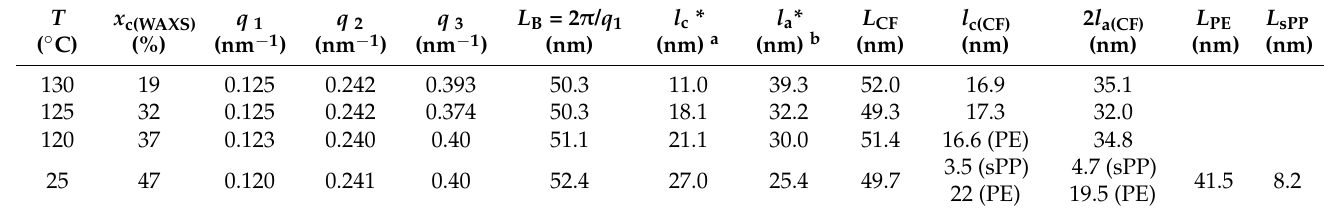
Table 2. Values of crystallinity x c (WAXS) evaluated from the WAXS diffraction profiles of Figure 3B, scattering vectors q = 4 π sin θ / λ of the three correlation peaks q 1 , q 2 and q 3 observed in the SAXS curves of Figure 5 recorded at different temperatures T during cooling from the melt of the sample PE-b-sPP-1 with f sPP = 53%, values of the corresponding long period ( L B and L CF ) evaluated from the scattering vector q 1 of the first correlation peak ( L B = 2 π / q 1 ) and from the self-correlation functions of electron density fluctuations of Figure 7 ( L CF ), values of the thicknesses of the crystalline lamellae l c and amorphous layers l a , evaluated from the SAXS profiles of Figure 5B and the values of the long period L B ( l c * and l a *) and from the self-correlation functions of Figure 7 ( l c(CF) and l a(CF) ), and values of the thickness of the PE and sPP domains ( L PE and L sPP